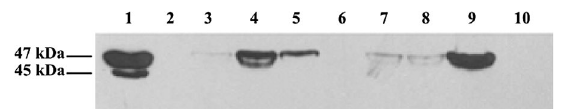
Fig. 3 Detection of the APA recombinant protein in tobacco plants. An anti-APA polyclonal antibody was used to detect the APA protein. Lane 1: 500 ng of APA purified from M. tuberculosis as positive control. Lane 2: Empty lane; Lanes 3–9: protein extracts from transgenic seeds. Lane 10: protein extract from wild-type Nicotiana tabacum seeds (negative control). The positions of the expected bands of 47 and 45 kDa are indicated on the